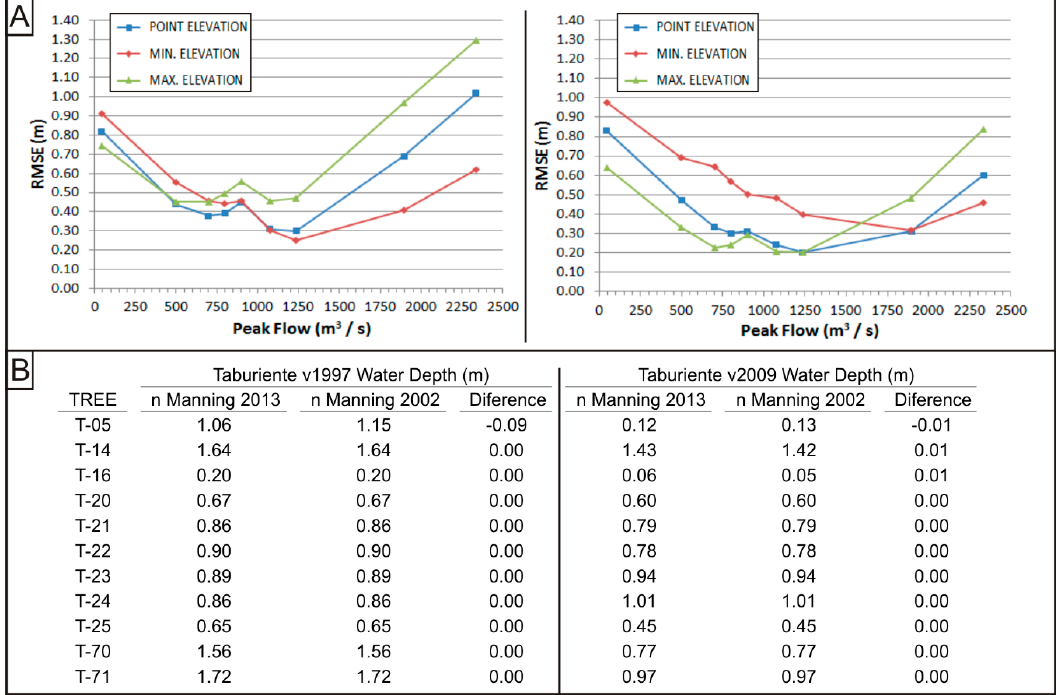
Figure 5. ( A ) Flow depth value for different modelled flows vs. the heights of the dendro- geomorphological evidence: results from the v2009 DEM (left) and v1997 DEM (right); ( B ) flow depth value difference on tree location due to surface roughness change sensitivity analysis.